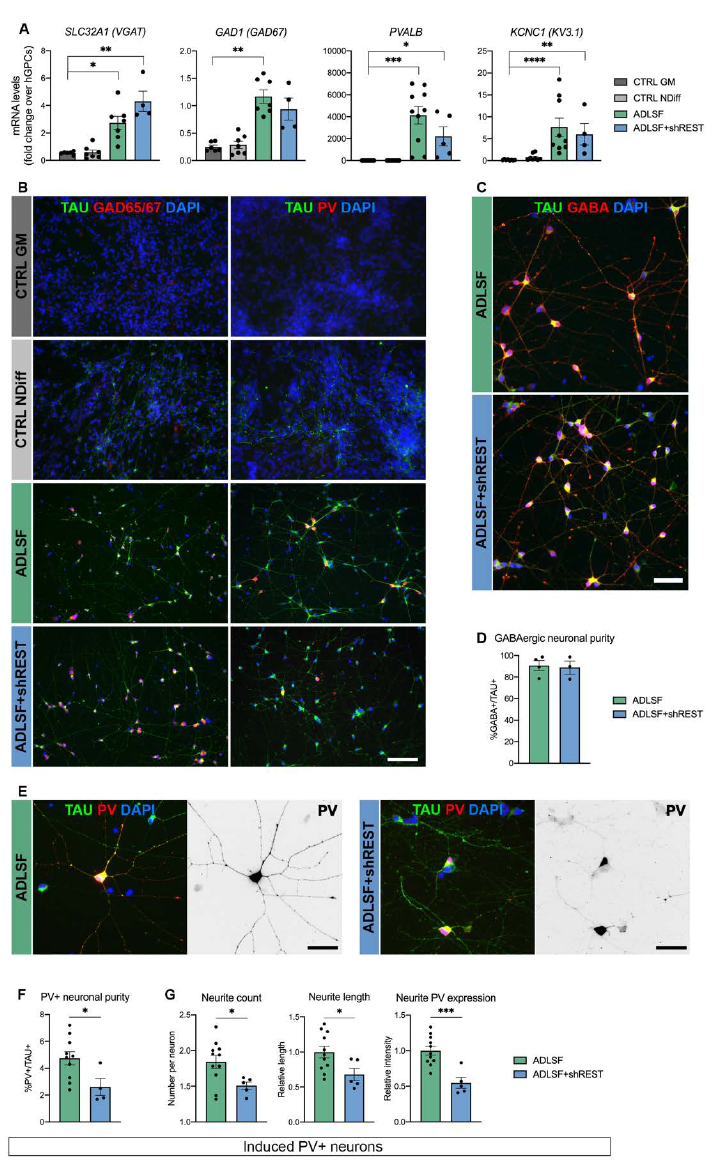
Figure 2. Generation of GABAergic interneurons with PV expression: ( A ) RT-qPCR analysis of GABAergic gene expression at 26 days after transduction. Kruskal–Wallis test, Dunn’s multiple comparisons test (n = 6–10 for CTRL GM, n = 7–9 for CTRL NDiff, n = 7–10 for ADLSF and n = 4–5 for ADLSF + shREST): **** p < 0.0001; *** p < 0.005; ** p < 0.01; * p < 0.05. ( B ) Immunocytochemistry of TAU + neurons expressing GAD65/67 and PV in ADLSF w/o shREST at 26 days after transduction. ( C , D ) GABA + /TAU + cells in reprogrammed cultures, ( C ) immunocytochemistry, and ( D ) quantification. No significative difference was detected between ADLSF (n = 4) and ADLSF + shREST (n = 3) using the two-tailed unpaired t-test. ( E ) Representative image of PV expression in neurites. Fluorescent images are shown in black and white and inverted for clarity. ( F ) Quantification of a higher PV + neuronal proportion in ADLSF condition. Two-tailed unpaired t-test (n = 10 for ADLSF and n = 4 for ADLSF + shREST): *, p = 0.032; df = 12. ( G ) Quantification of neurite profile in PV + / TAU + neurons. Two-tailed unpaired t-test (n = 11 for ADLSF and n = 5 for ADLSF + shREST): neurite count, * p = 0.034; df = 14; neurite length, * p = 0.033; df = 14; neurite PV expression, *** p = 0.0007; df = 14. Data are presented as mean ± SEM. Each datapoint represents a replicate from an independent experiment. For the measurement of neurite length and PV expression, each datapoint is normalized to the mean of ADLSF condition. Scale bars: ( B ) 100 µ m; ( C , E ) 50 µ m. See also Figure